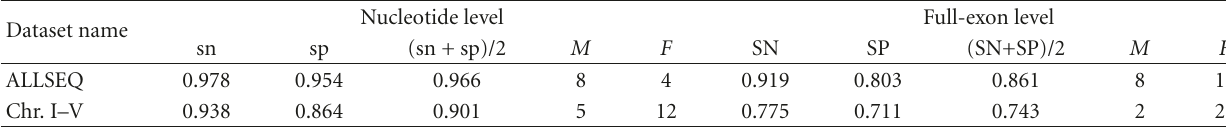
Table 9: Maximum accuracy of metastate HMM for the parameter values tested.